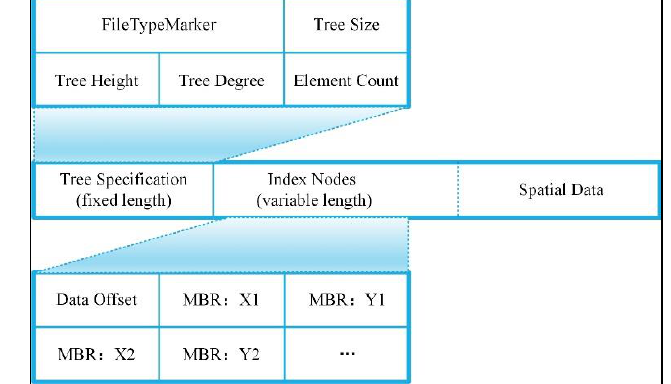
Figure 3. R-tree Local Index